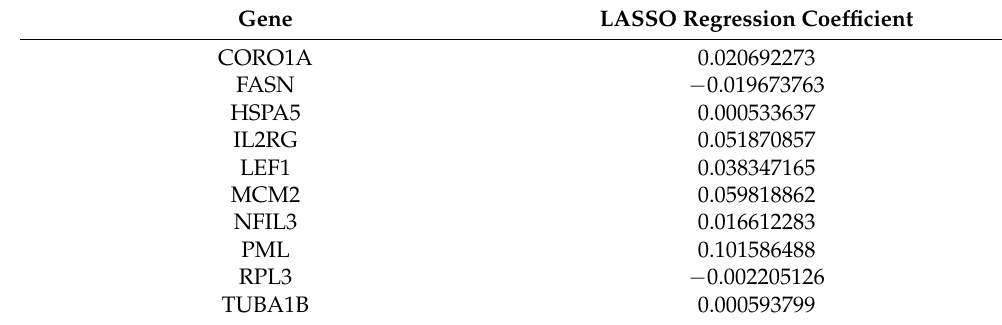
Table 1. Univariate Cox regression analysis and LASSO regression coefficients of 10 genes generated by LASSO regression